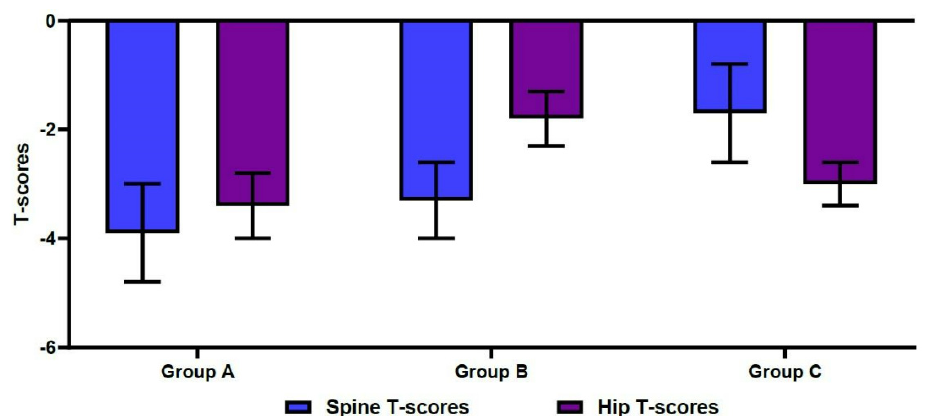
Figure 3. Differences in spine/hip T-scores on dual-energy X-ray absorptiometry.